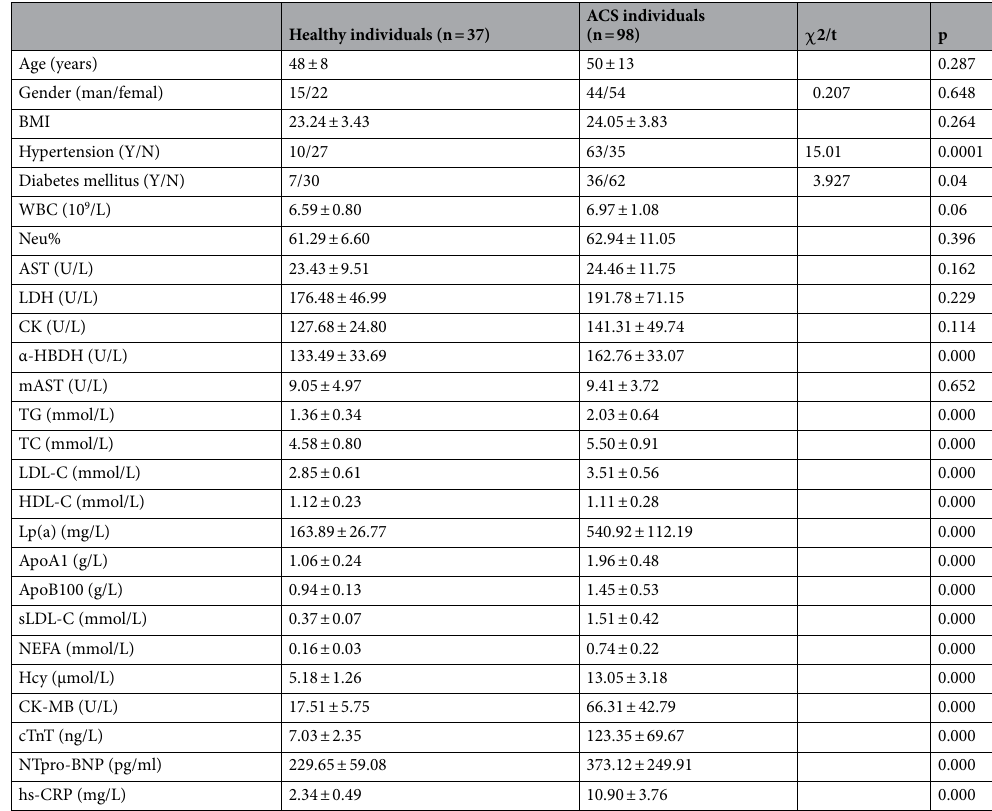
Table 1. Characteristics of the ACS individuals and healthy individuals. Abbreviations : BMI, Body Mass Index; WBC, white blood cell; Neu, neutrophil; AST, Aspartate aminotransferase; LDH, lactate dehydrogenase; CK, Creatine Kinase; α-HBDH, alpha-hydroxybutyric dehydrogenase; mAST, Aspartate aminotransferase mitochondrial isoenzyme; TG, TG; TC, Total Cholesterol; LDL-C, Low-Density Lipoprotein Cholesterol;